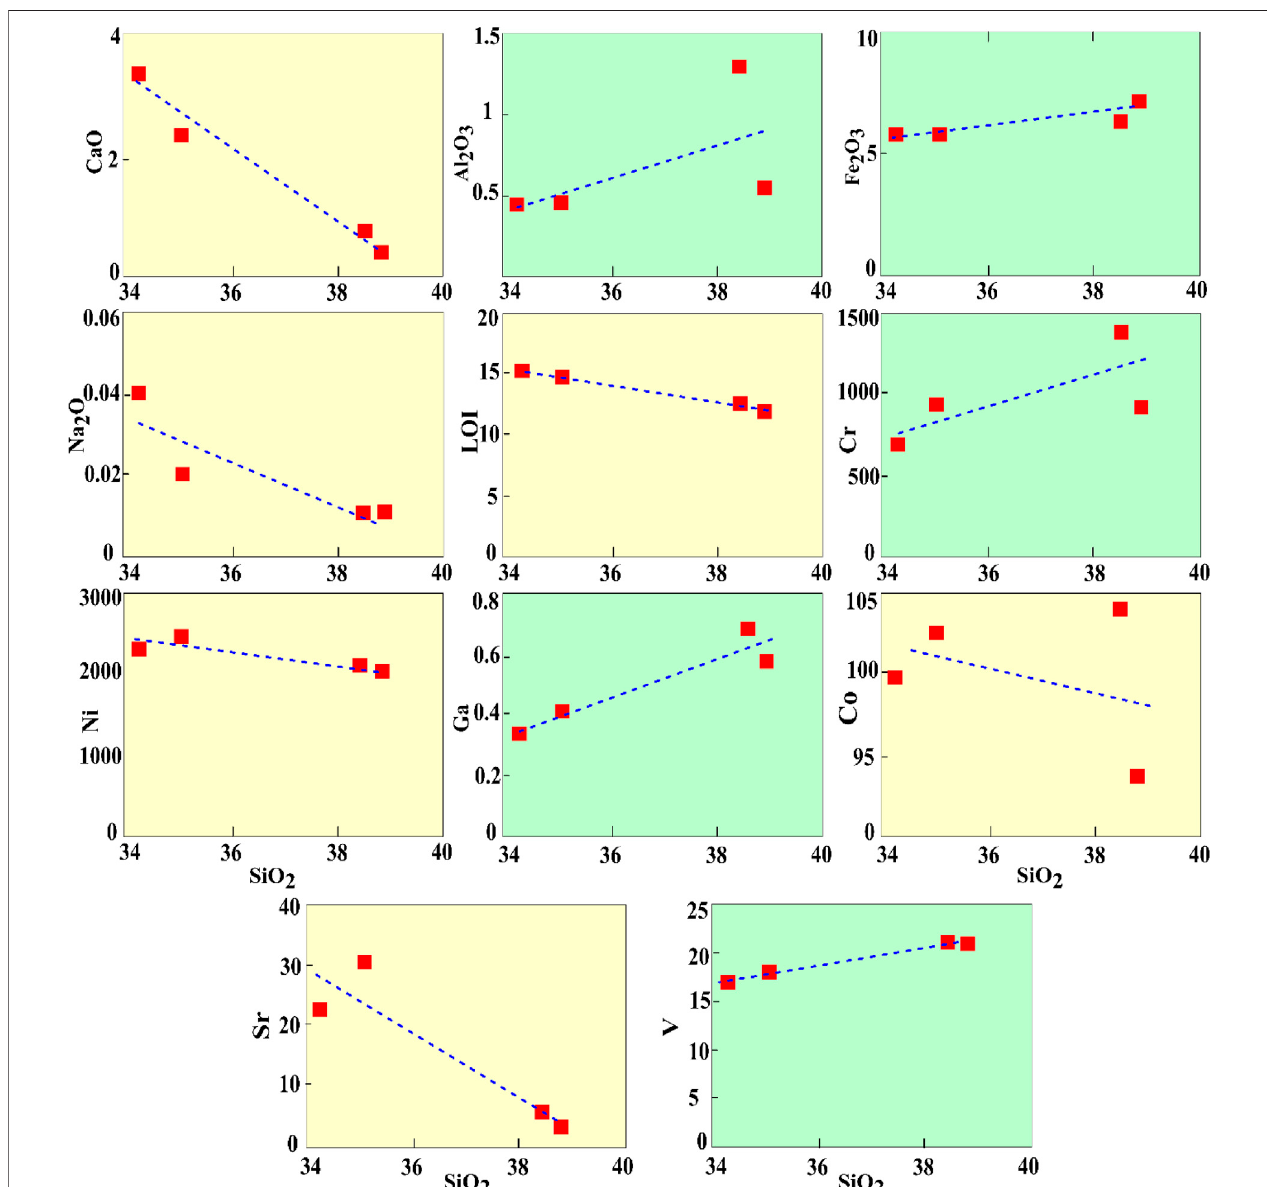
FIGURE 6 | Major and trace element versus SiO 2 bivariate plots for the serpentinite samples.